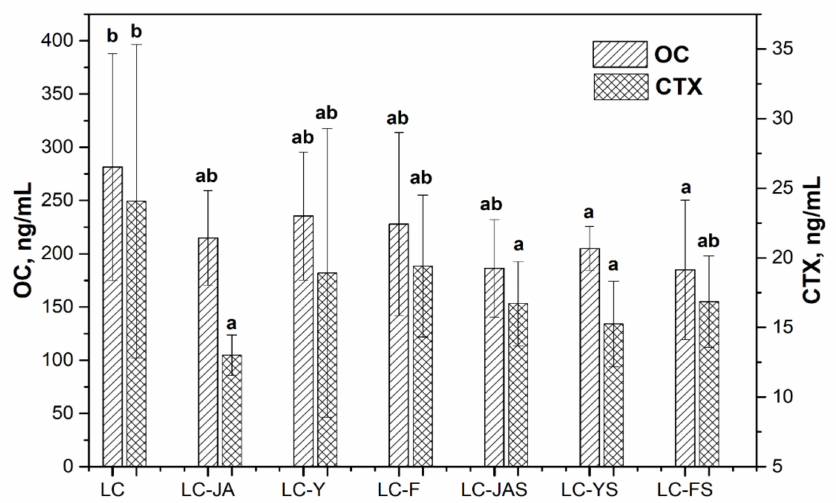
Figure 1. Changes in OC and CTX levels in rat serum after 12 weeks of feeding animals with the low-calcium diets enriched with fructans compared to LC group. a,b—different small letters mean significant differences among low-calcium groups, separately, for each parameter ( p <